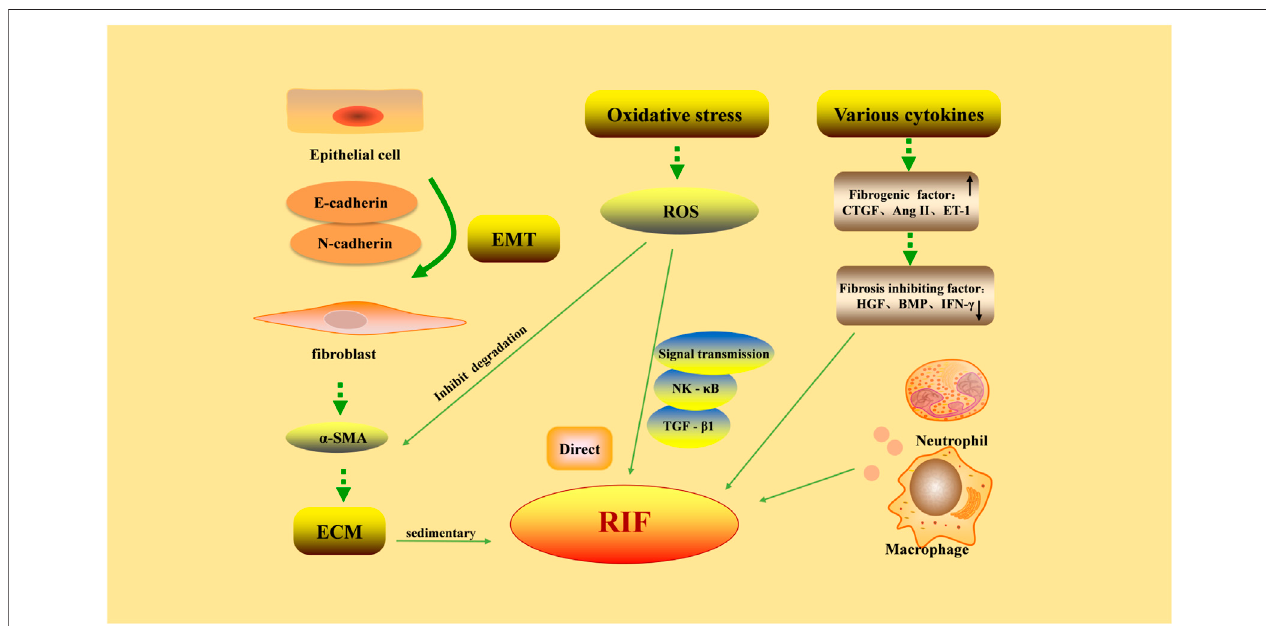
FIGURE1| Pathologicalfactorsinrenalinterstitial fi brosis.Excessivedepositionofextracellularmatrix(ECM)isthemaincauseofrenalinterstitial fi brosis.Epithelial- mesenchymal transition (EMT) refers to the phenotypic transformation of epithelial cells to fi broblast-like cells by acquiring a mesenchymal morphology, through decreased expression of E-cadherin and increased expression of N-cadherin. The proliferation of fi broblasts is the precursor of ECM overproduction. The factors promoting/inhibiting fi brosis restrict each other, and the dynamic balance is lost, leading to the formation of fi brosis. The damaged part of renal interstitium can be rapidlyin fi ltratedbyalargenumberofin fl ammatorycells,aggravating fi brosis.Theabnormalincreaseinreactiveoxygenspecies(ROS)generationduringoxidativestress can directly induce pathological damage to various renal cells and reduce the degradation of ECM by mesangial cells. On the other hand, ROS can participate in intracellular signaling pathways as a signaling molecule, causing